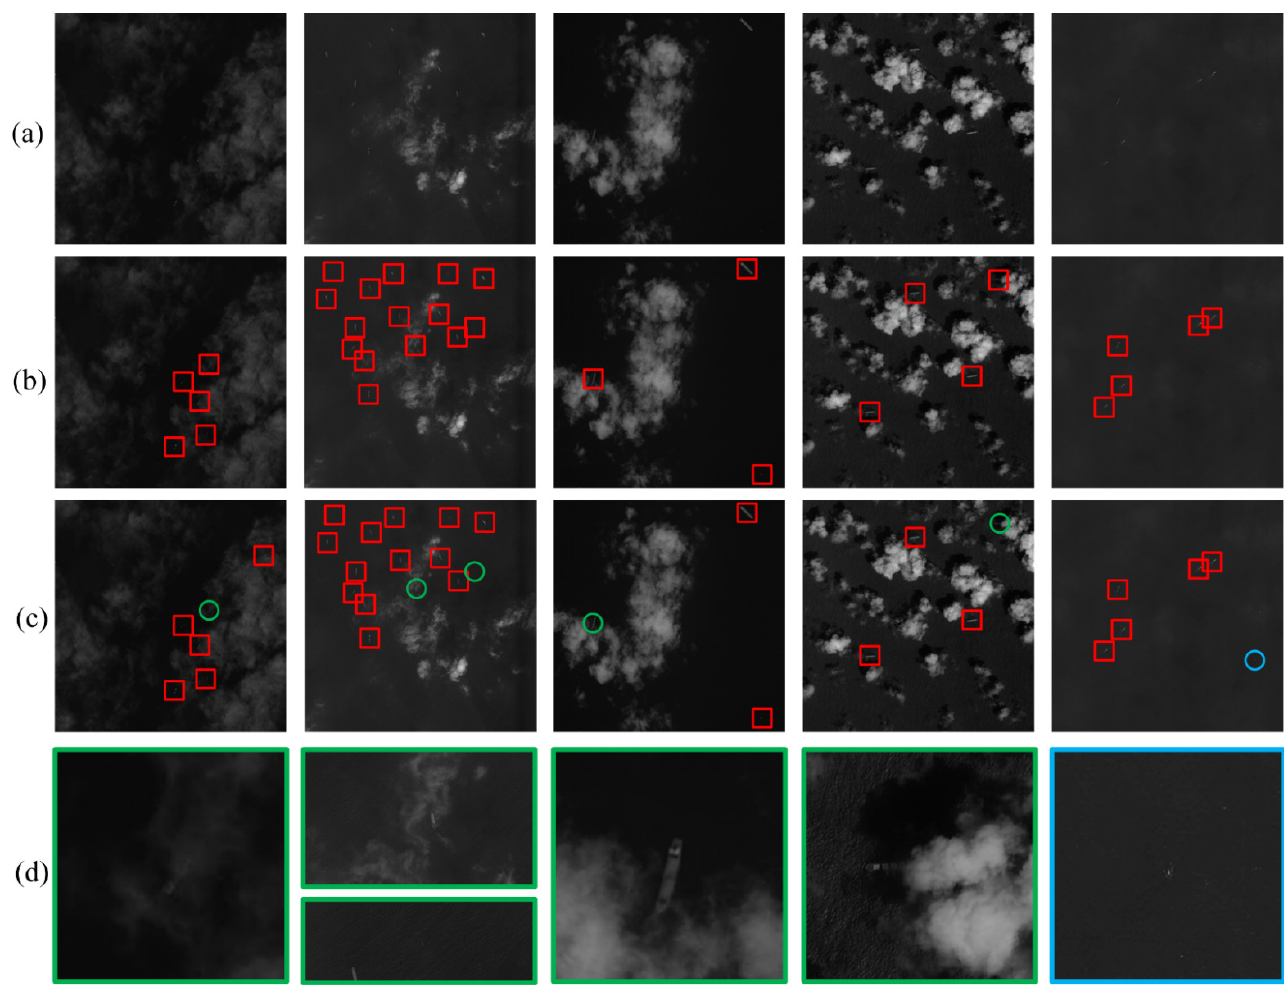
Figure 11. The experimental results are compared with images and detailed enlarged images. ( a ) the data image of the GF-1 remote sensing satellite; ( b ) the detection result of our SFCFAR algorithm; ( c ) the detection result of the Nie algorithm; ( d ) a partial enlarged image. Red boxes represent detected ships, green circles represent undetected targets and blue circles represent detected false targets. Table 2. The information corresponding to each image in Figure 11. It includes the latitude and longitude information, and imaging date information, of each subfigure in Figure 11. The calibration type of the image is